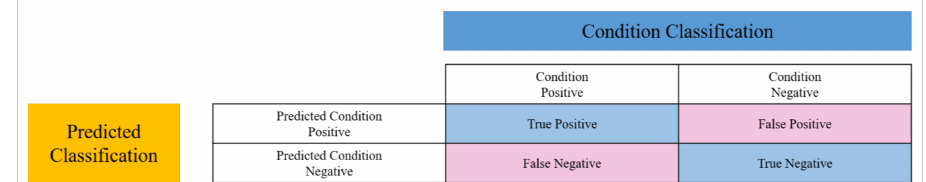
Figure 9. The confusion matrix for the face recognition system for evaluating overall